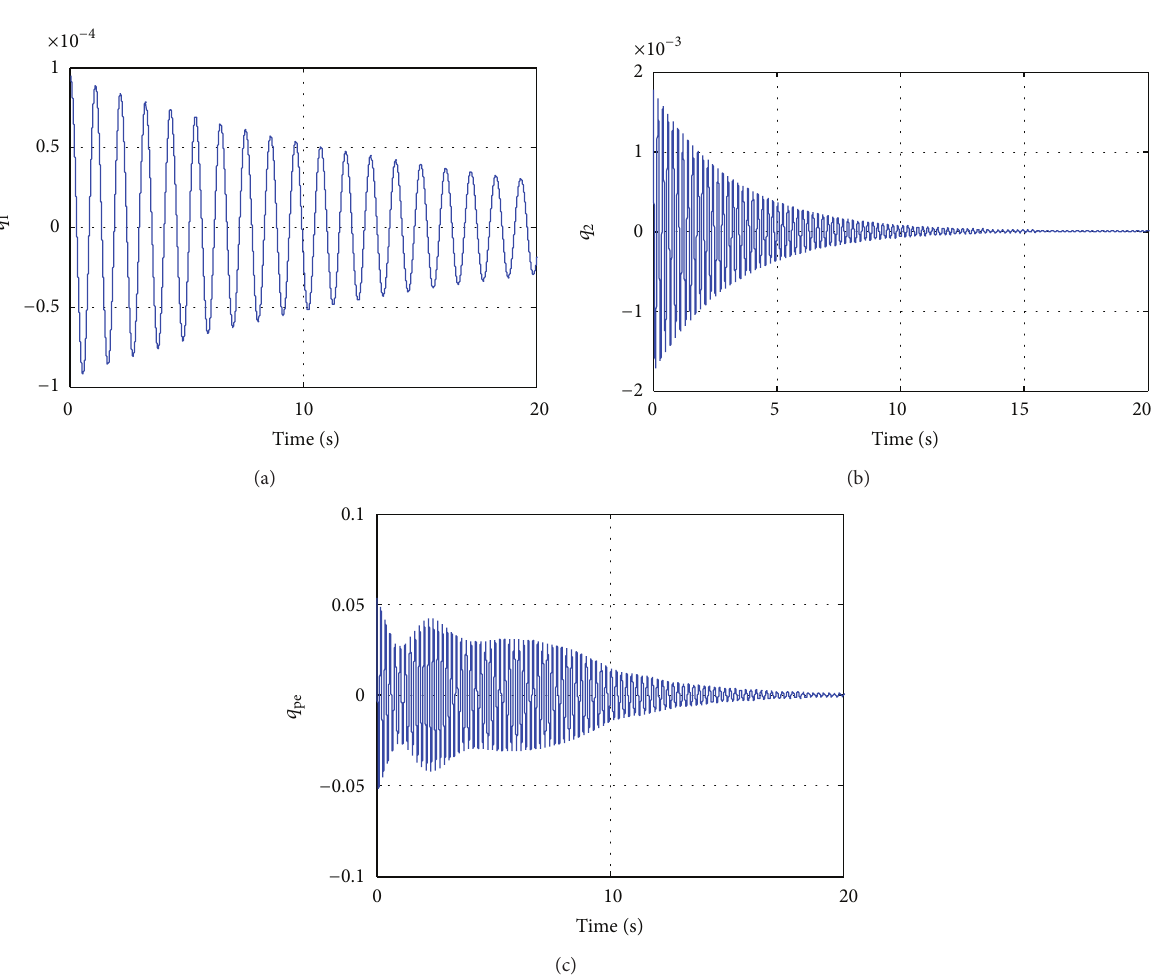
Figure 10: Feedback-linearisation: response at 97.5 ms −1 (assumed-modes